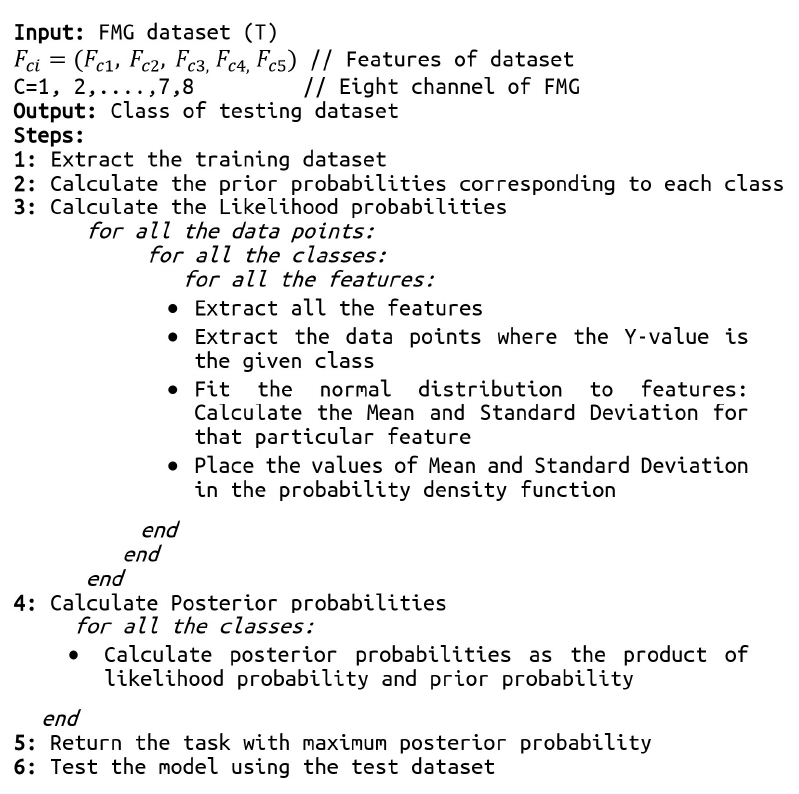
Figure 5. The pseudo-code of the skills assessment using the naïve Bayes algorithm.